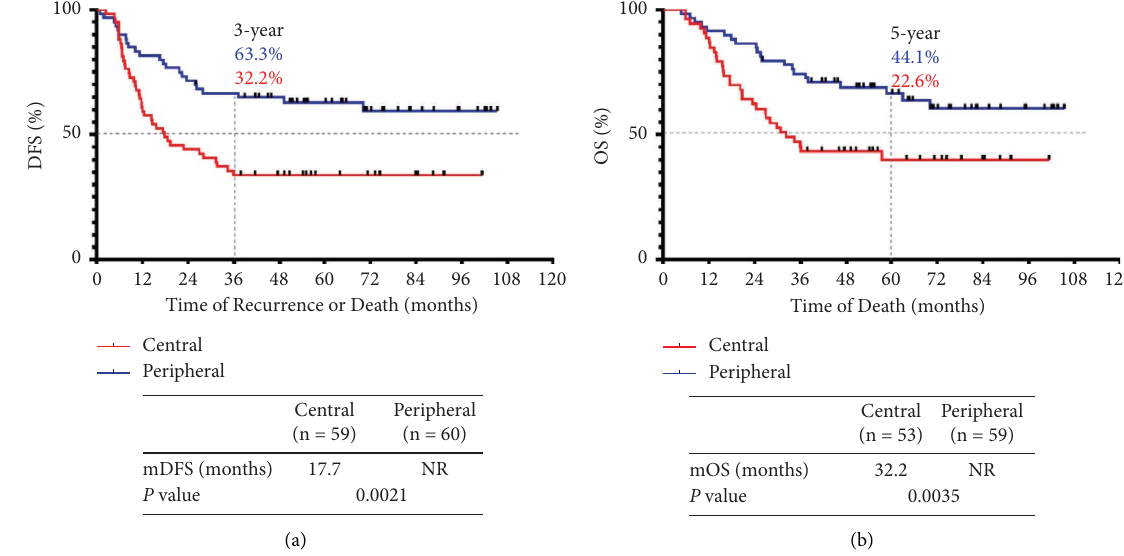
Figure 4: Identifcation and prognostic signifcance of tumor location in resected LS SCLC patients. (a) Te DFS curves of resected LS SCLC patients with central ( n � 59) and peripheral ( n � 60) tumors. (b) Te survival curves of resected LS SCLC patients with central ( n � 59) and peripheral ( n � 60)